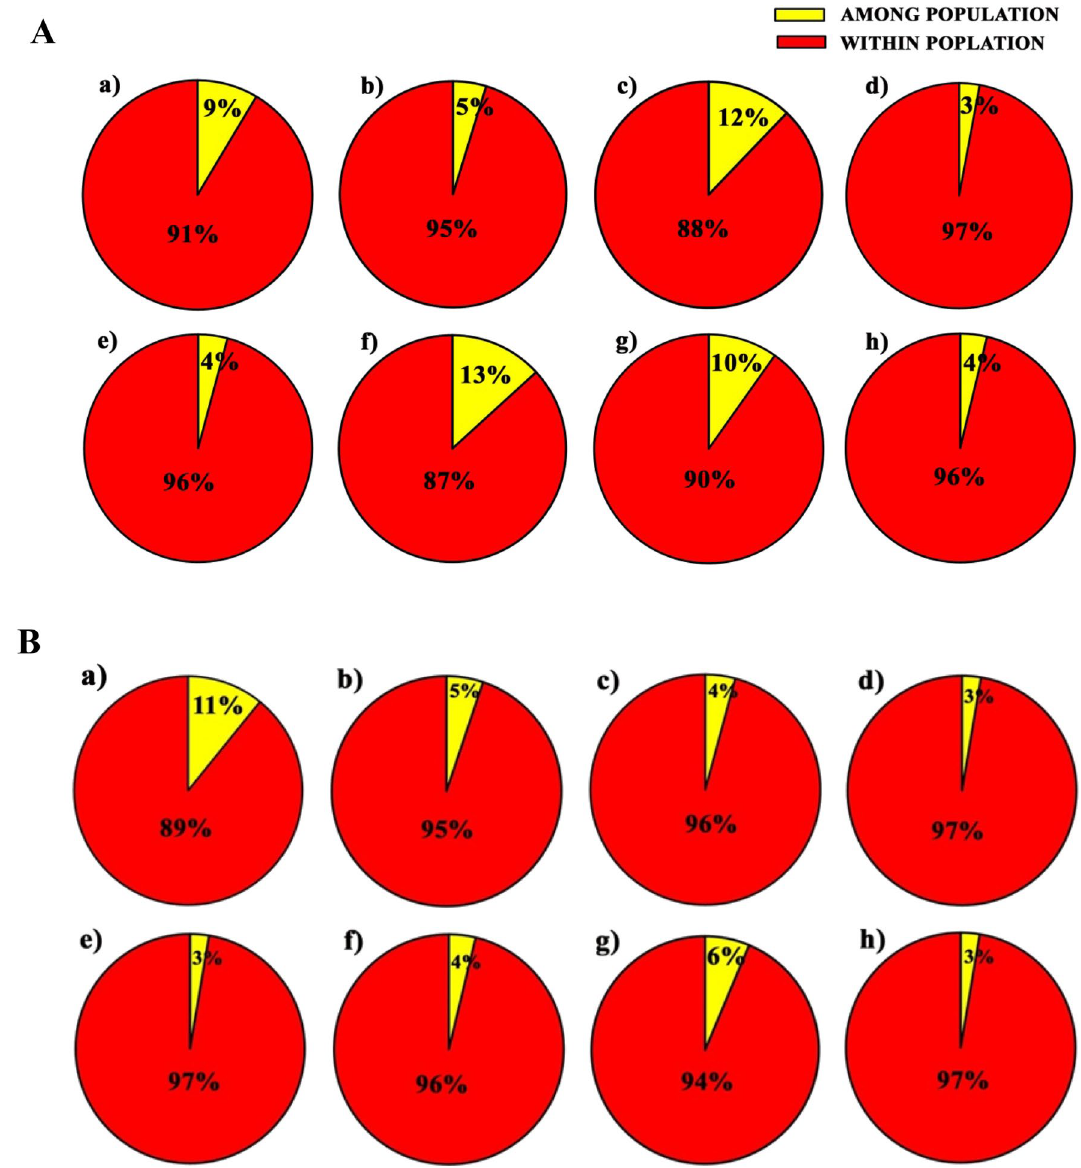
Figure 1. AMOVA analysis of ( A ) 4 Geographical Populations (East India = EI, West India = WI, North India = NI, South India = SI) and ( B ) Fruit Status Populations (S = Selection, H = Hybrid and L = Landrace) of selected Indian mangoes based on individual and cumulative DNA marker systems: ( a ) RAPD ( b ) ISSR ( c ) DAMD, ( d ) SCoT ( e ) CBDP ( f ) SSR ( g ) RAPD + ISSR + DAMD (h) SCoT +